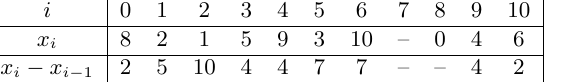
, , , , 0 , 8 1 , 2 3 , 5 4 , 9 6 , 10 {{ } { } { } { } { }}